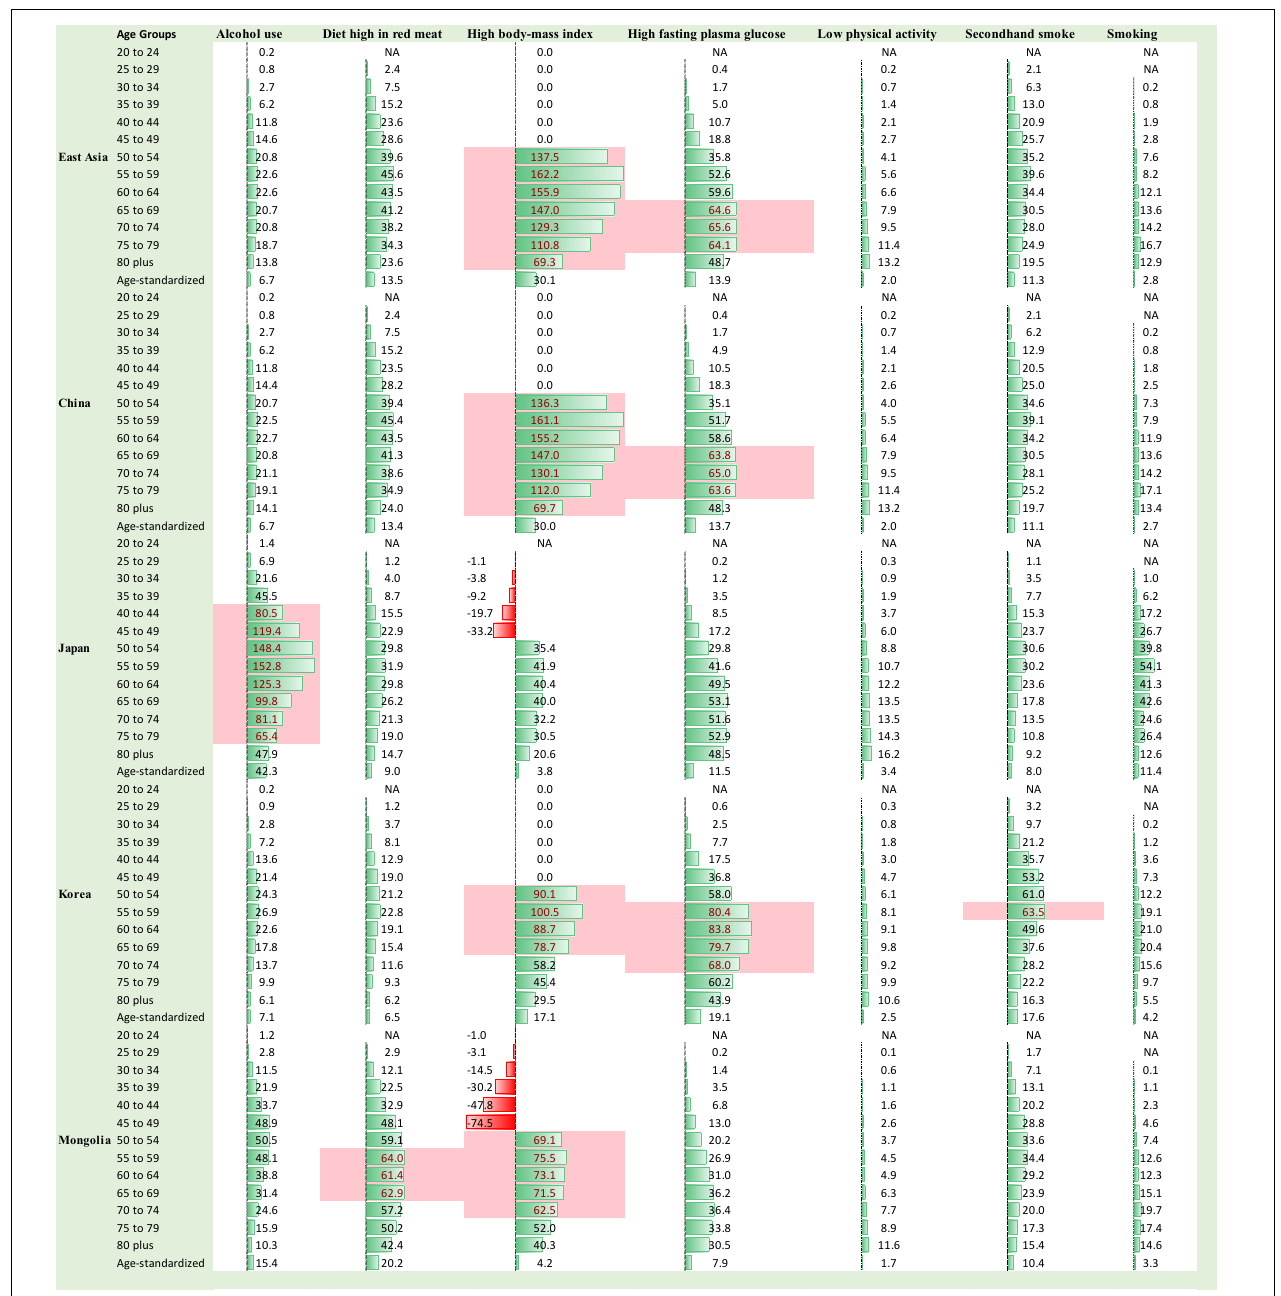
FIGURE 5 | Female DALYs (rate per 100,000) due to BC in 2019 stratified by age group 20 to 80+ years, age-standardized rate, and by risk factors in East Asia, the value with pink background fall in the rank of top 10%, NA = data are not available for those age groups and risk